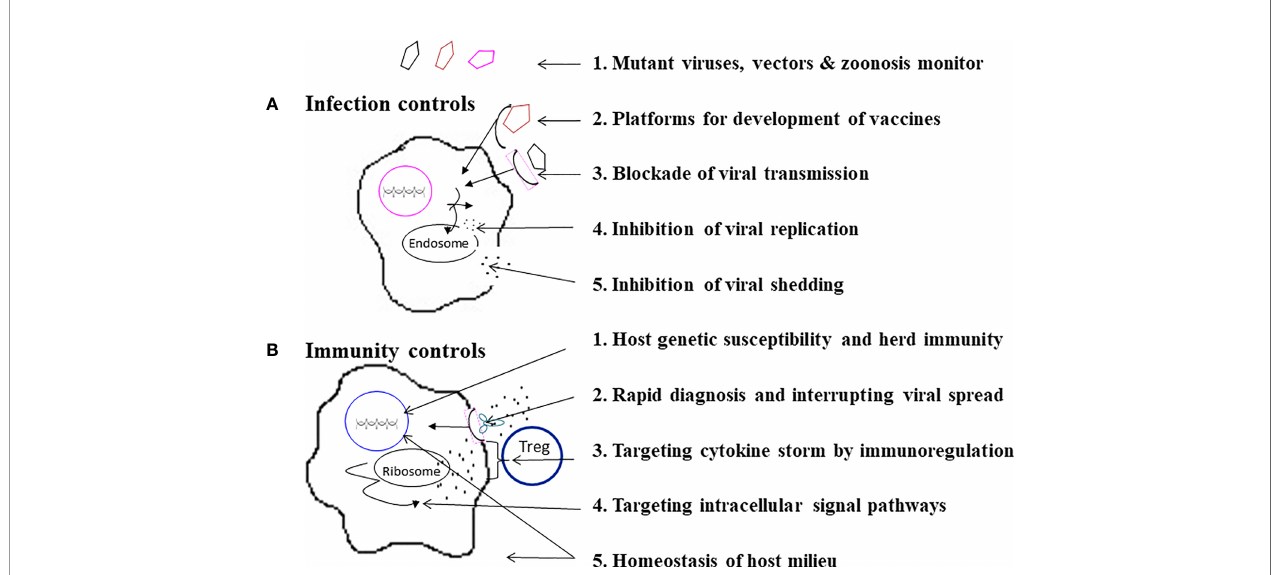
FIGURE 5 | A stepwise practical guide to do infection controls and immunity controls. As speci fi ed, (A) Infection controls can be made by a 5-step program, and (B) Immunity controls can be approached by another 5-step